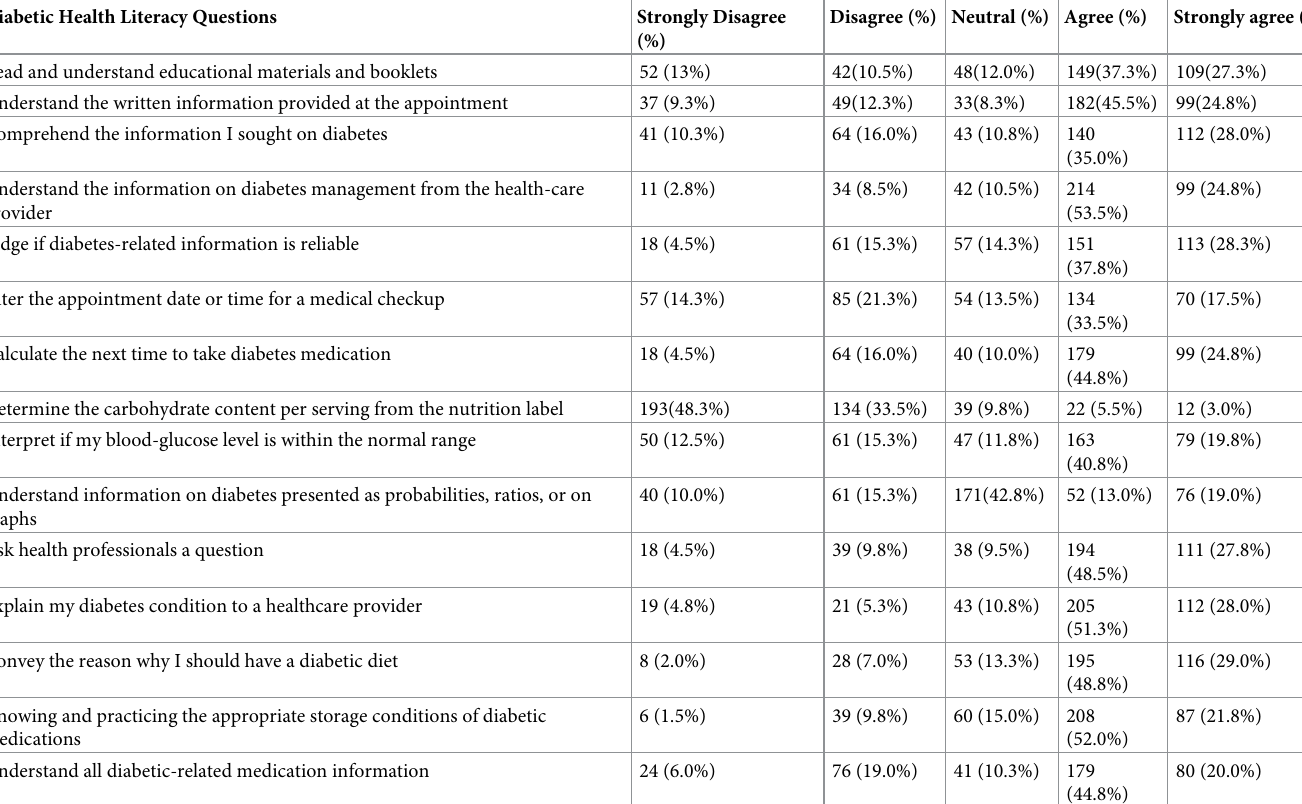
Table 2. Diabetic health literacy of the diabetic patients at the outpatient clinic of UOGCSH, 2019 (N = 400). Diabetic Health Literacy